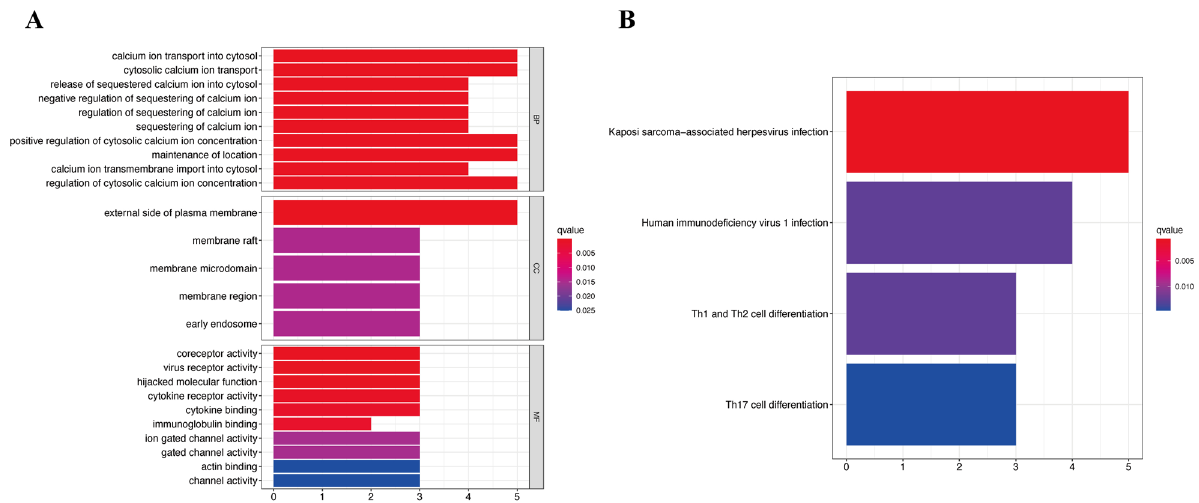
Figure 11. Function analysis of progression-associated OS genes. ( A ) Top 10 classes of GO enrichment terms about 13 hub genes in biological process (BP), cellular component (CC), and molecular function (MF). ( B ) KEGG enrichment terms about 13 hub progression-associated OS